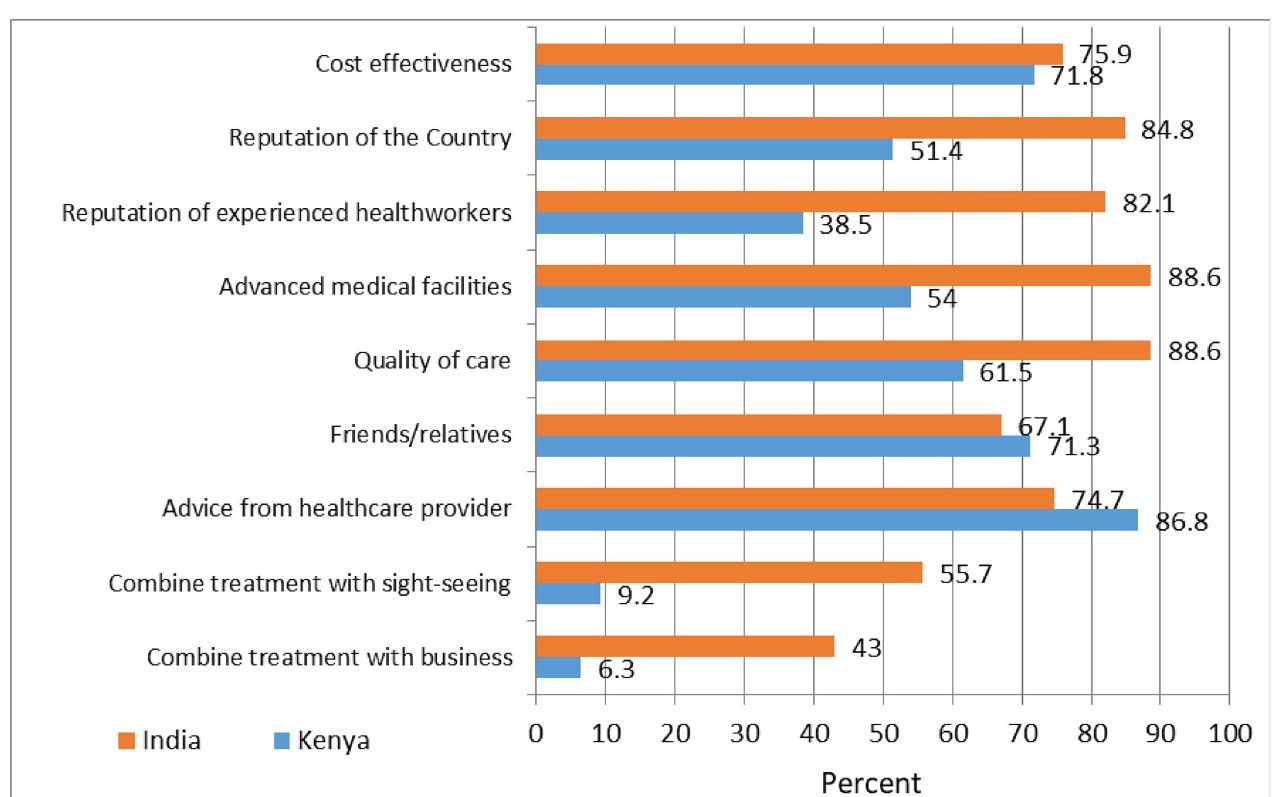
Fig 3. Proportion of study respondents and the influencing factors for choice of treatment center. NB: Reputation of the country refers to the respondent’s perception that the Country has the reputation to offer the required specialized cancer treatment health services.